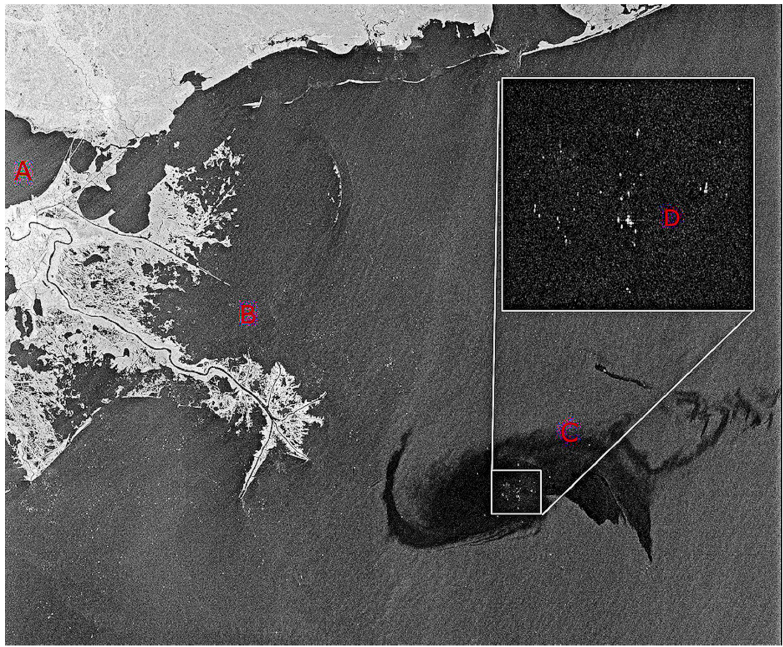
Figure 7. Radarsat imagery of the Deepwater Horizon spill. The square shows an expanded view of the center of the spill area and the bright dots are ships working to control the spill.